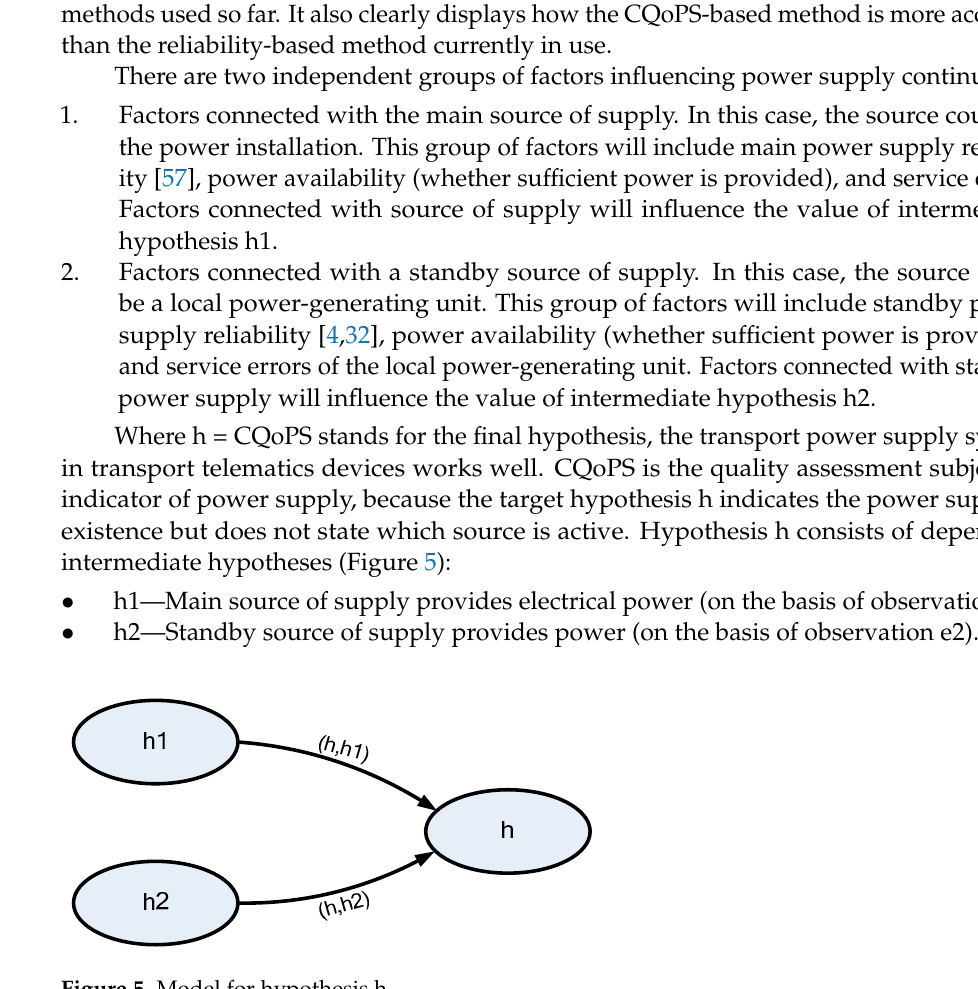
Figure 5. Model for hypothesis h.